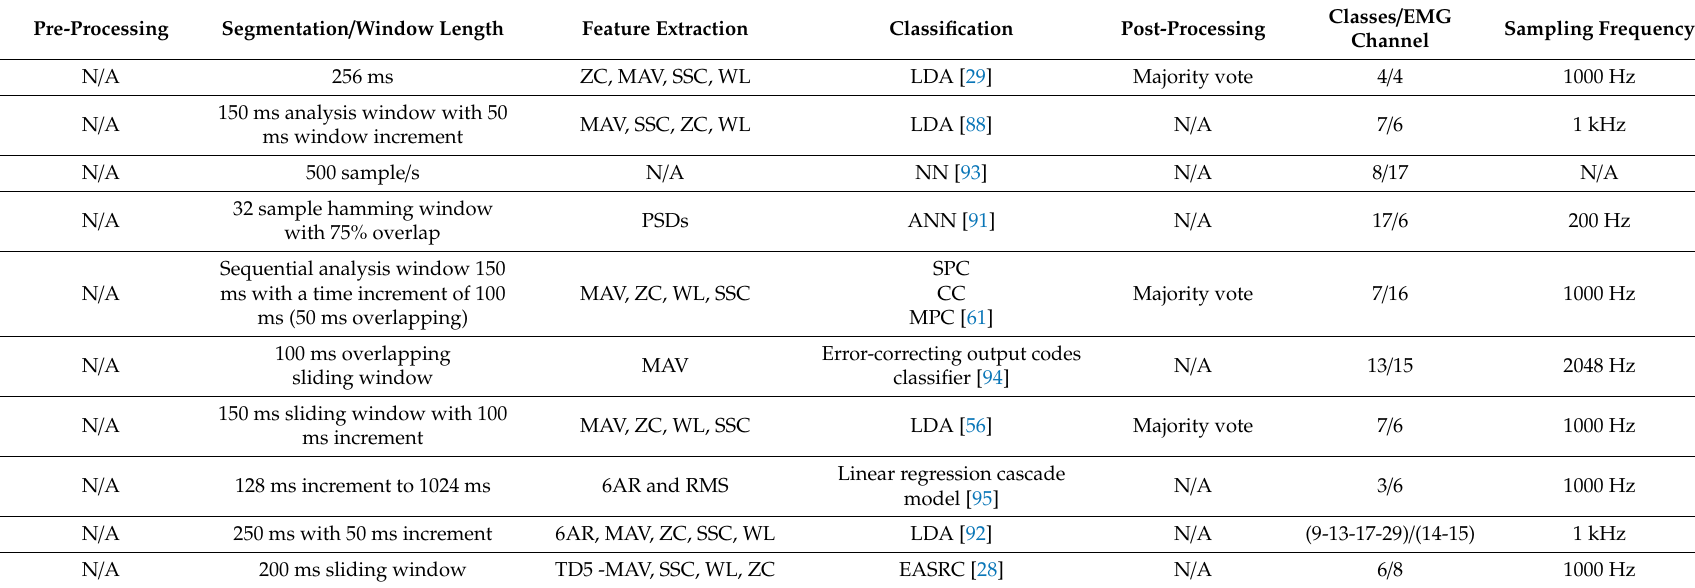
Table 3. Summary of real-time analysis with a virtual